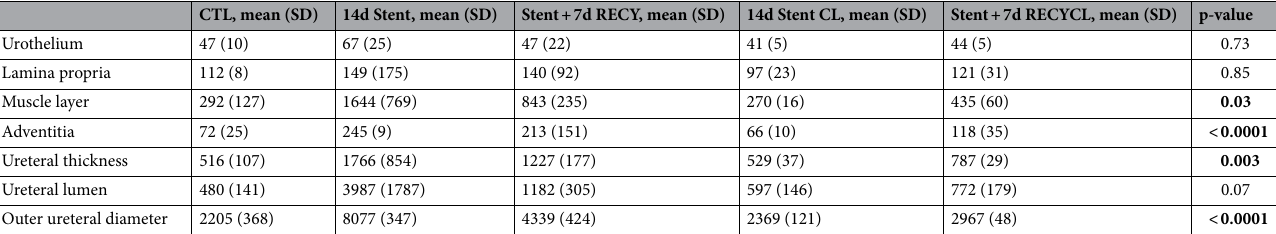
Table 1. Histomorphological changes following ureteral stenting (µm). Significant values are in